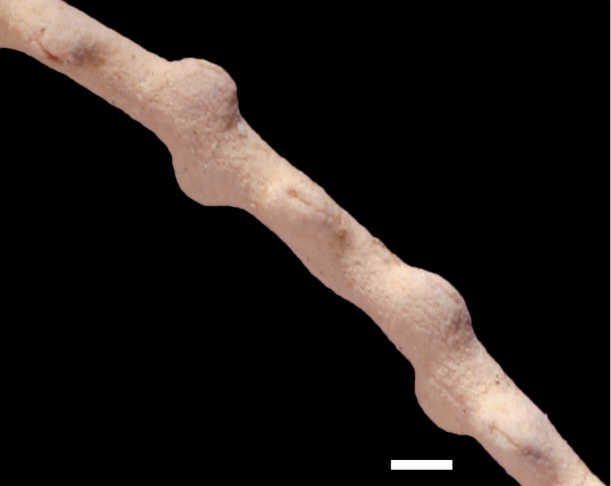
Leptogorgiafilicrispa, SBMNH 423057-Holotype. Close-up of branch, showing spacing of polyps; Scale bar: 1.0 mm. Image originally published as figure 1C in Horvath (2011, Proceedings of the Biological Society of WA, 124: 1, 47).